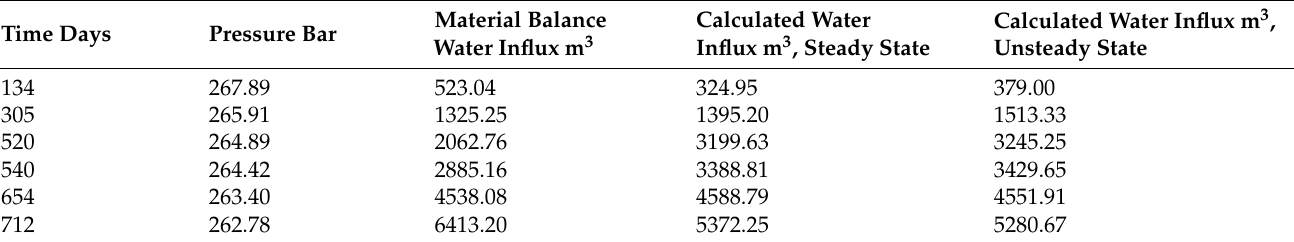
Table 7. Results of water influx match for Hummar formation.